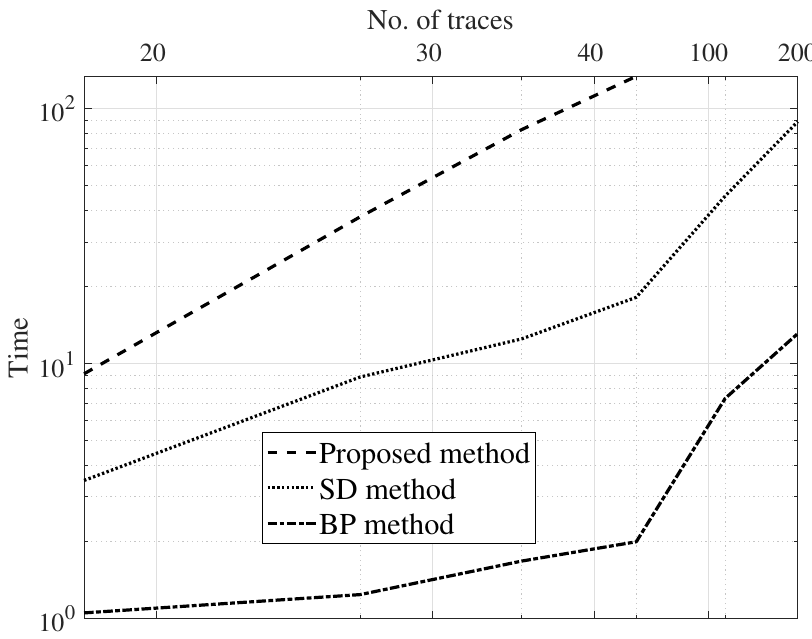
Figure 10. Simulation time versus number of